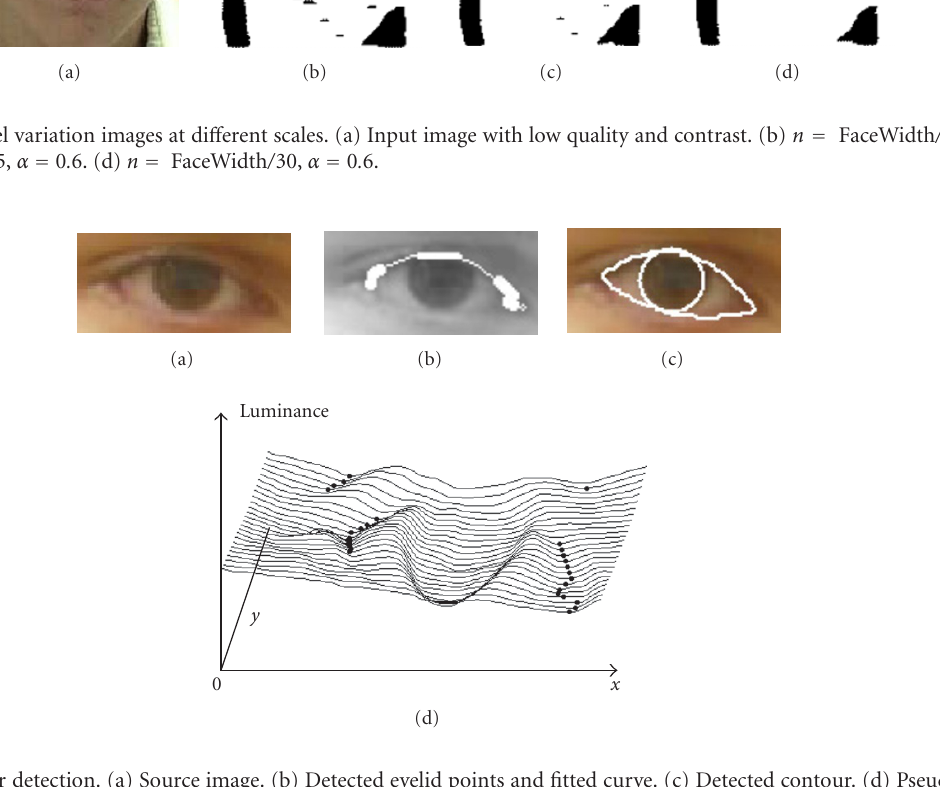
Figure 5: Eye contour detection. (a) Source image. (b) Detected eyelid points and fitted curve. (c) Detected contour. (d) Pseudo 3D lumi- nance graph of the eye area. Candidate points for eye border are marked with dark